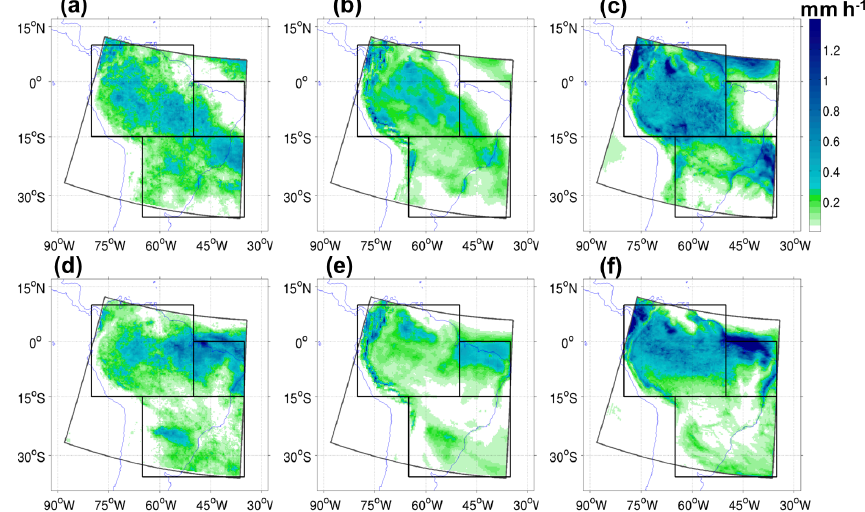
Figure 4. Monthly mean precipitation (mmh − 1 ) on the 35km resolution domain (dark gray line) for November 2008 from (a) TRMM 3B43, (b) CCATT-BRAMS, and (c) WRF-Chem and for May 2009 from (c) TRMM 3B43, (d) CCATT-BRAMS and (f) WRF-Chem. The subregions for the precipitation comparison are indicated by black lines.